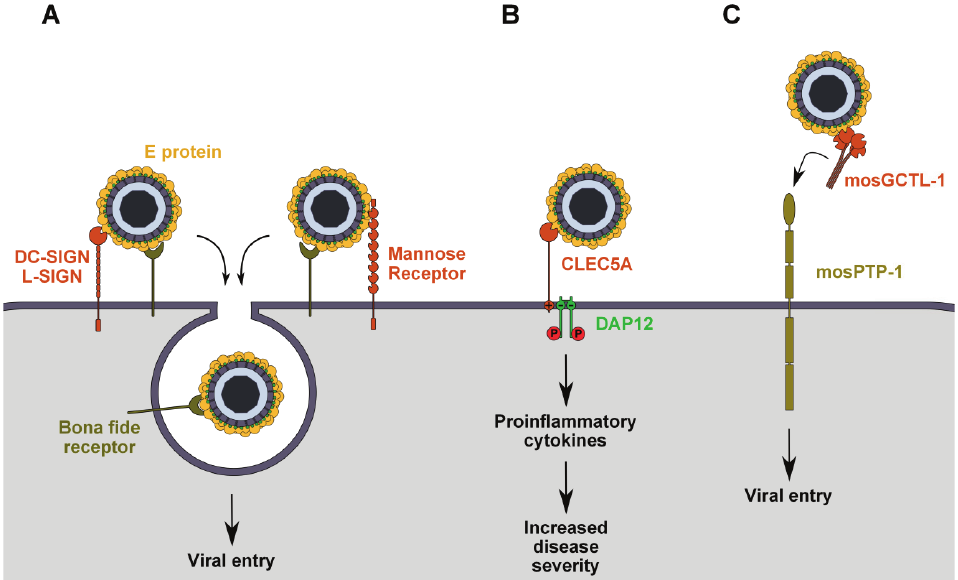
Figure 1. Attachment of flaviviruses to C-type lectin receptors has different implications in flaviviruses infections. ( A ) In mammalian cells, DC-SIGN/L-SIGN and the mannose receptor (MR) act as attachment factors that bind virions and facilitate their entry by transferring them to the bona fide receptor(s) involved in endocytosis; ( B ) In mammalian cells, binding of flaviviruses to CLEC5A triggers DAP12 phosphorylation and downstream signaling pathways that lead to the release of pro-inflammatory cytokines and aggravation of the disease; ( C ) In mosquitoes, virus entry is facilitated by the binding of virus/mosGCTL-1 complexes to cellular